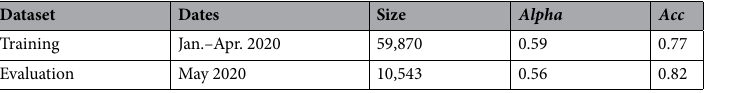
Table 2. The annotation results for the training and evaluation datasets: date range, size (no. of comments annotated twice), and the annotator agreement in terms of interval Krippendorff’s Alpha and accuracy ( Acc ).